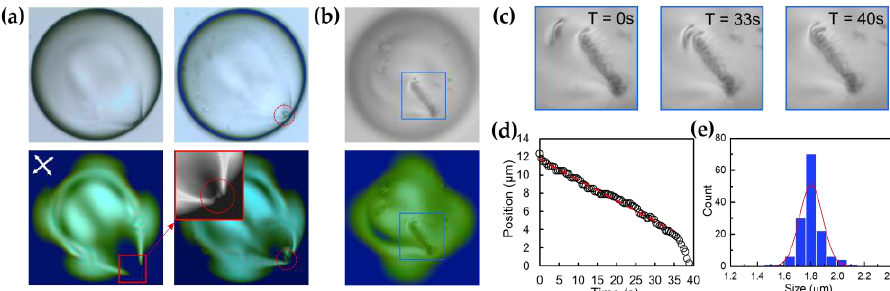
Figure 4. Laser processing of a CLC droplet with an internal quill-like structure. ( a ) Laser irradiated (127 µW, 20 s) the target CLC droplet with N = 3.5 and loaded guest water NDs into it. ( b , c ) For each irradiation, the injected NDs were organized into a curved chain and self-assembled as a single unit. ( d ) Time-sequenced position of curved chains for their self-assembly dynamics. ( e ) Size distribution of NDs in (b).